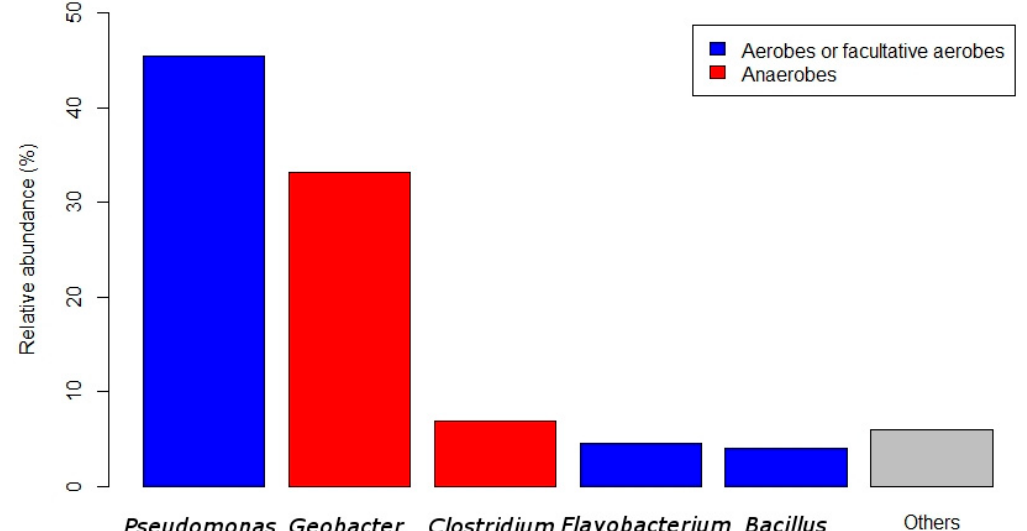
Figure 4. Microbial community composition of the anodic biofilm at the genus level.